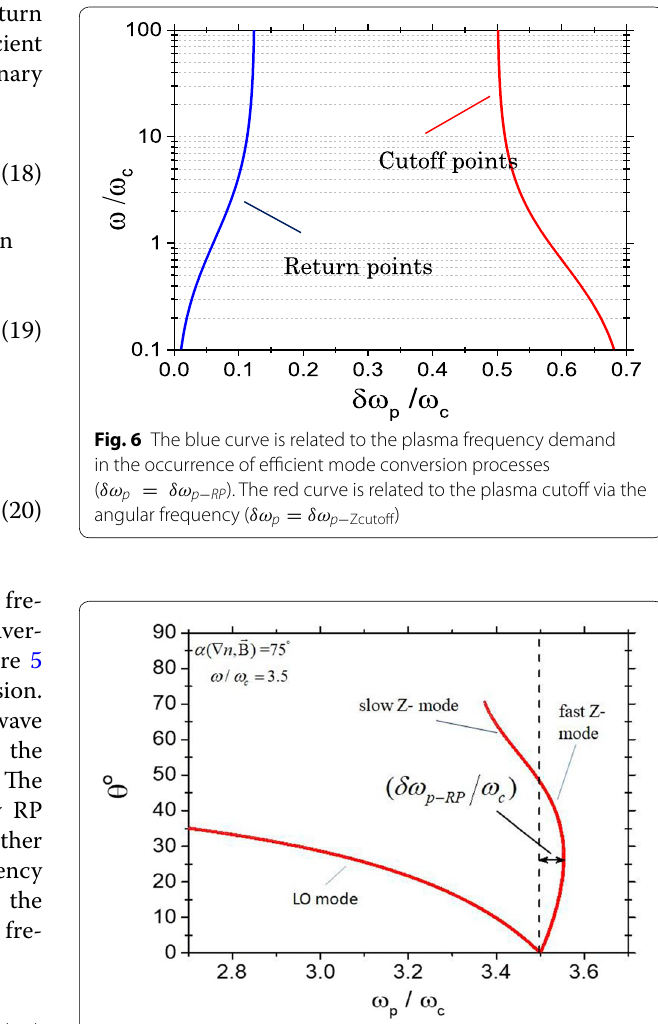
ω c N is not perpendicular (cid:31) ∇